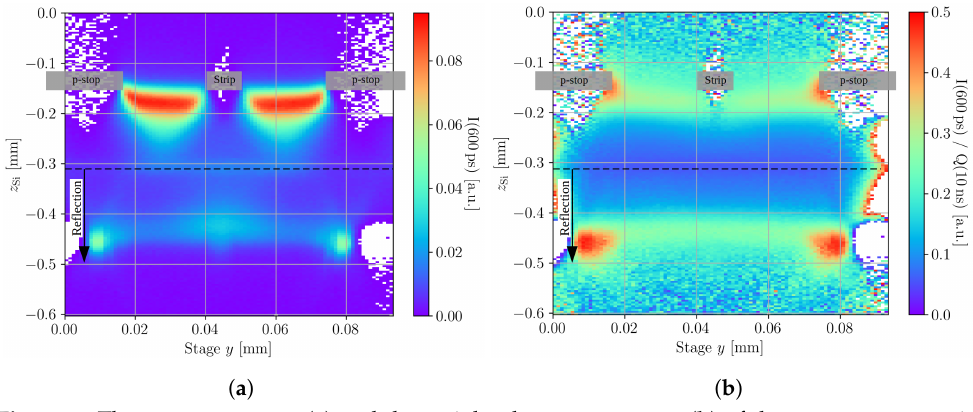
Figure 6. The prompt current ( a ) and the weighted prompt current ( b ) of the same yz -scan as in Figure 4 are presented. In contrast to the prompt current and the collected charge profile, the weighted prompt current profile does not show intensity related artefacts. The devices back side is indicated by the black dashed line and the readout strip’s metal and the metals above the p-stop are shown schematically by the transparent grey boxes.